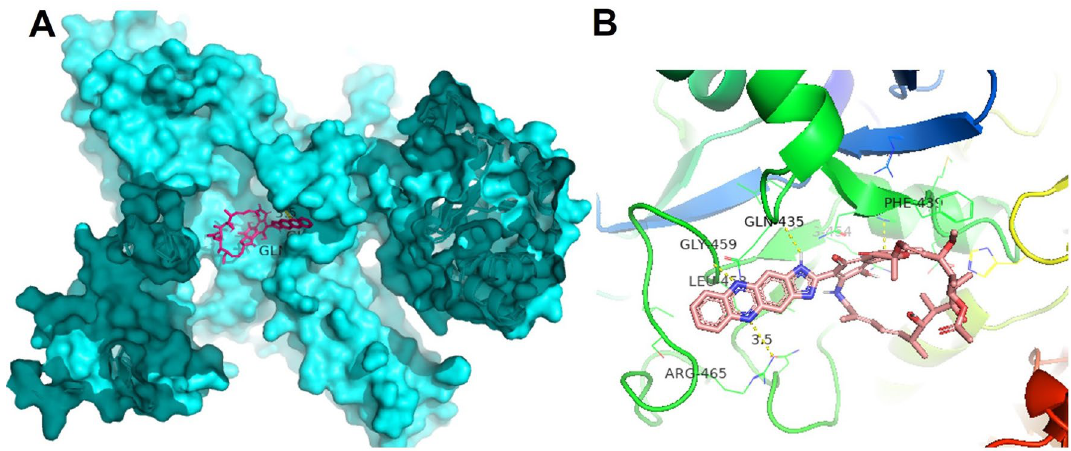
Figure 4. ( A ) Binding of RPZ at the active site of Mtb RNA polymerase. ( B ) The yellow lines depict the hydrogen bond interactions of the residues in the β-chain of the RNA polymerase with the inhibitor RPZ. The figure was visualized using the PyMOL molecular graphics system (Version 2.4.0, Schrödinger, LLC, https :// www.pymol